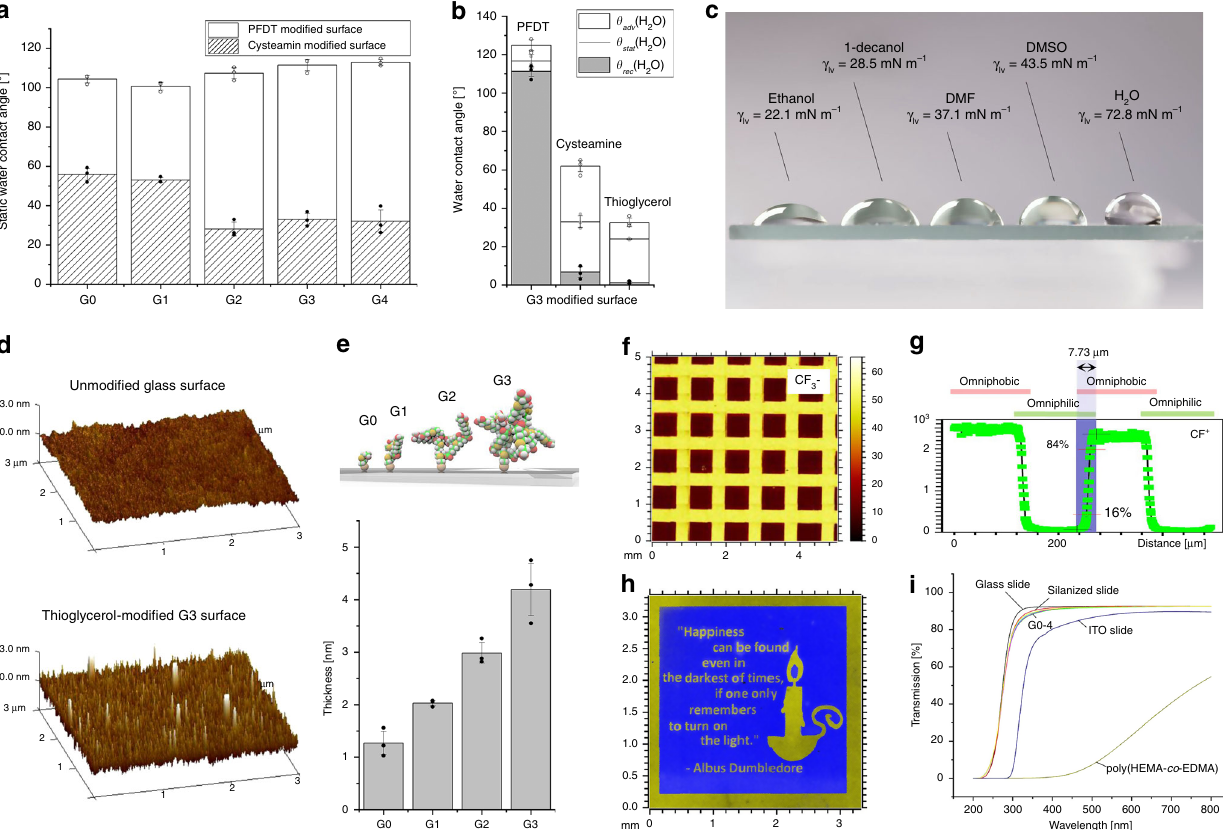
Fig. 3 Characterization of dendrimer-grafted surfaces. a Static water contact angles of PFDT-modi fi ed (omniphobic) and cysteamine-modi fi ed (omniphilic) G0 – 4 surfaces. b Advancing, static and receding water contact angles of G3 surface with different functionalizations (PFDT, cysteamine and thioglycerol). c Photograph of droplets of various low and high surface tension liquids on an omniphilic – omniphobic-patterned G3 surface. From left to right: ethanol ( γ lv = 22.1 mNm − 1 ), 1-decanol ( γ lv = 28.5mNm − 1 ), dimethyl formamide ( γ lv = 37.1mNm − 1 ), dimethyl sulfoxide ( γ lv = 43.5mNm − 1 ), and water ( γ lv = 72.8mNm − 1 ). d AFM images of an unmodi fi ed glass surface and a thioglycerol-modi fi ed G3 surface. e Schematic visualization of thioglycerol-modi fi ed G0 – 3 surfaces and corresponding coating thicknesses measured by AFM. f ToF-SIMS analysis of lateral distribution of CF 3 − signals showing PFDT – thioglycerol — omniphilic – omniphobic — surface patterning. Spot size: 700×700 µ m 2 . Color scale: [counts]. g CF + line scan perpendicular to a PFDT stripe pattern having 250 µ m pitch, including indication of patterning fi delity by step analysis applying the 84/16% criterion. Lateral resolution of ~8 µ m between PFDT-modi fi ed and thioglycerol-modi fi ed G3 areas. h ToF-SIMS stage scan of a customized pattern. Blue: CF 3 ; yellow: Sum of CH 3 O, C 2 H 5 O, and C 4 H 5 O. i UV – Vis transmission spectra showing optical properties of thioglycerol-modi fi ed G0 – 4 glass surfaces, unmodi fi ed glass slide, ITO slide, and poly(HEMA-co-EDMA) surface. Data represent mean±standard deviation based on triplicate experiments; n = 3 independent experiments. Source data are provided as a Source Data fi